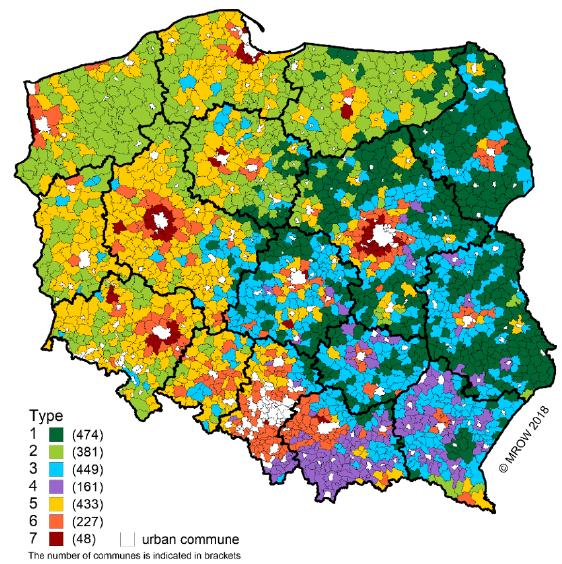
Figure 2. Spatial distribution of the types of rural areas. Source: own